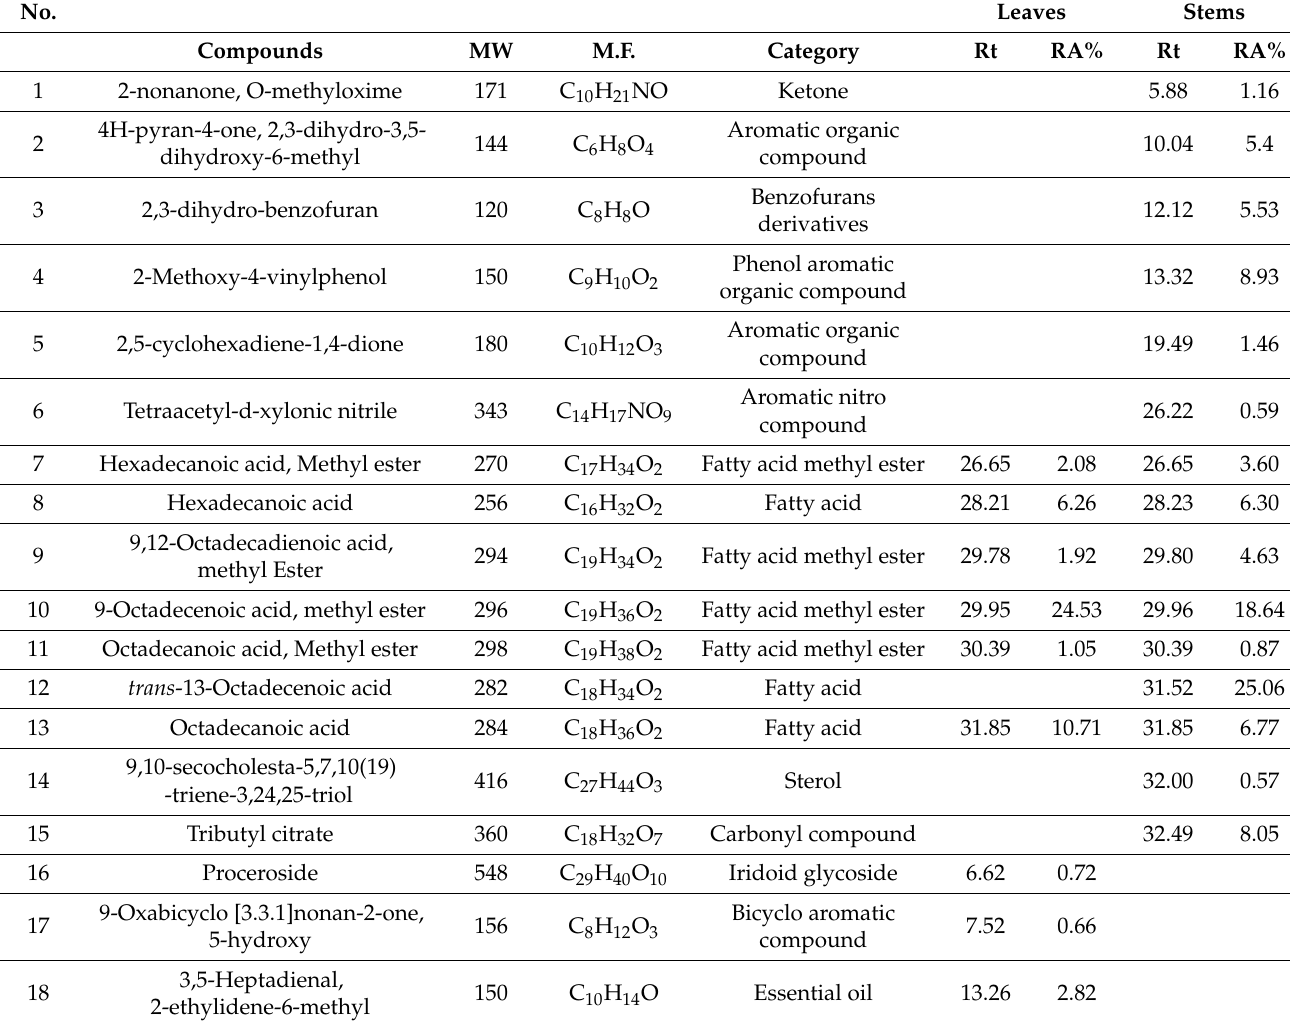
Table 1. Biological compound identification of methanol extract from Calystegia silvatica leaves and stems using